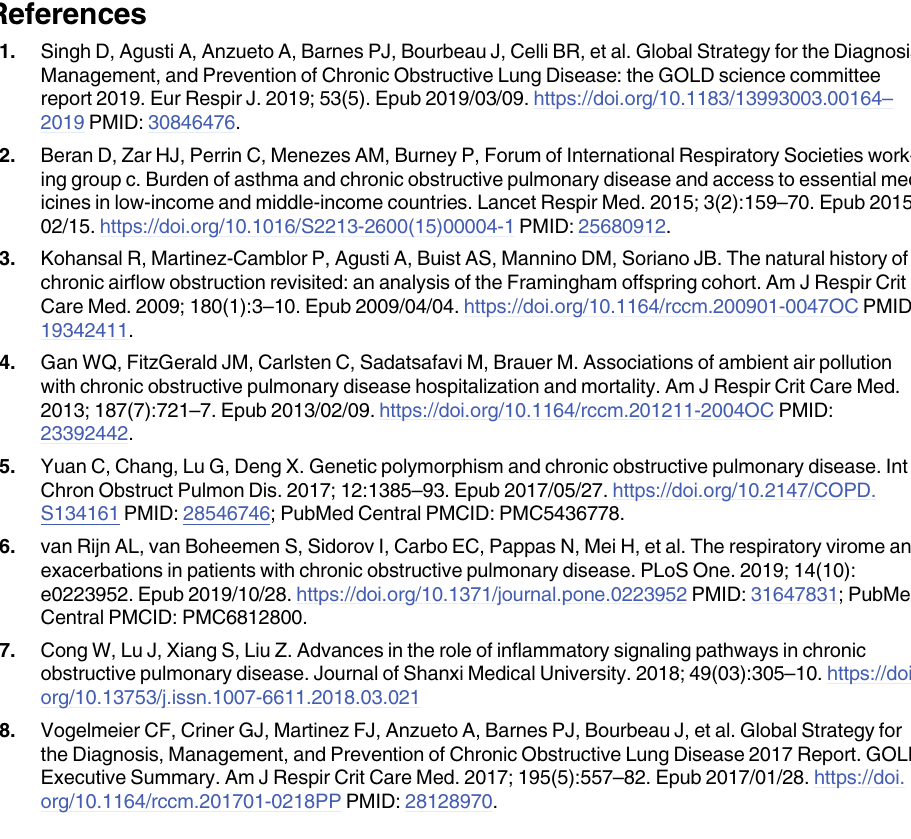
S2 Fig. The docking results of luteolin, kaempferol and bergenin binding to the five tar- gets. S1 Table. The detailed information of components identified in AJH based on UPLC-Orbi- trap Fusion MS. S2 Table. The details of network pharmacology